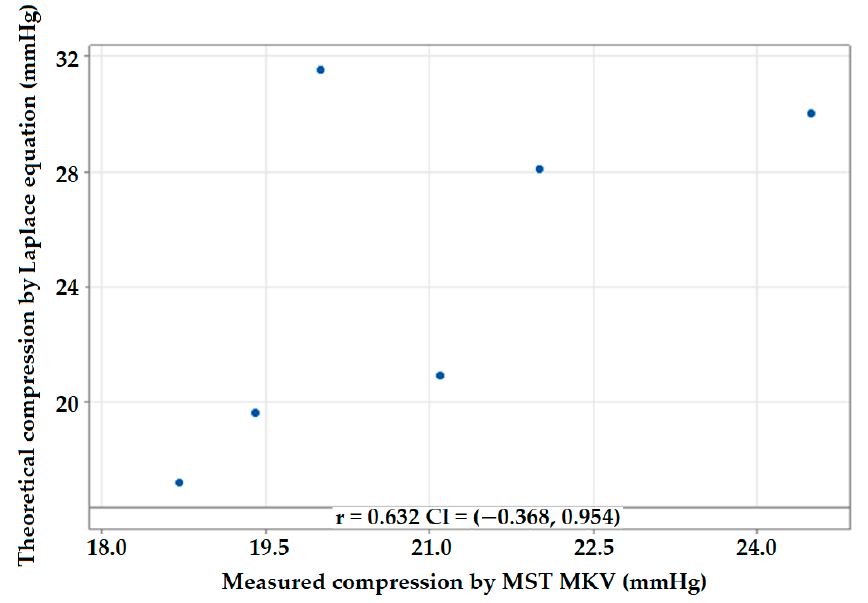
Figure 7. Correlation between measured and calculated compression